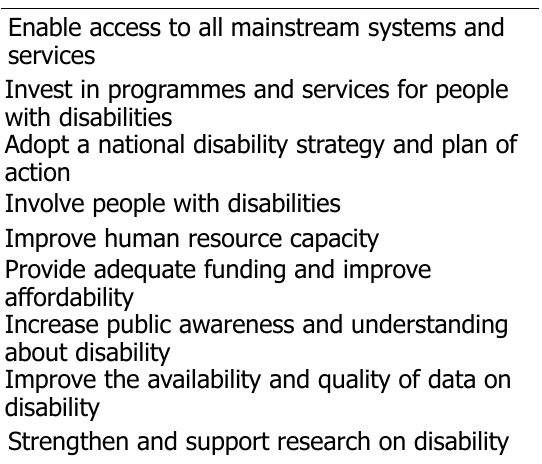
Table 1. Main recommendations of the